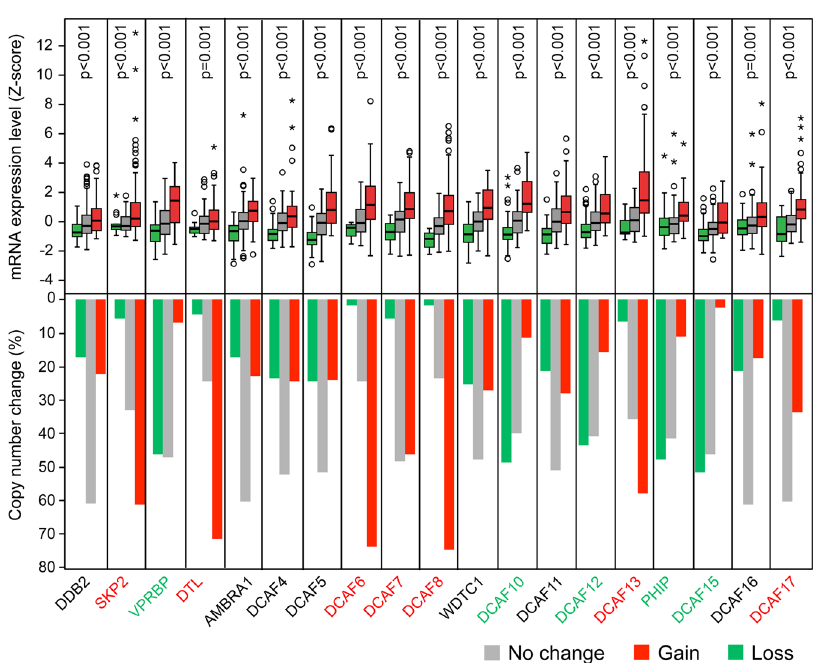
Figure 2. DCAF gene expression is strongly correlated with its DNA copy number in lung adenocarcinoma. The relationship between tumor DNA copy number and gene expression for 19 DCAFs in LuADCs is shown in top panel. Significance was determined using Kruskal-Wallis test. Bottom panel shows the percent of tumors with DNA copy number change. Tumors with increased DNA copy number (Gain) are indicated in red and those with decreased DNA copy number (Loss) in green. Tumors with no change in DNA copy number are indicated in